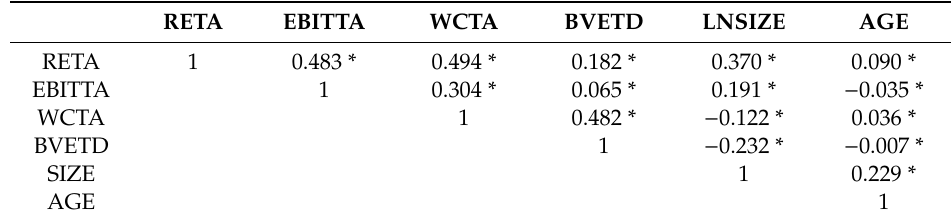
Table A1. Correlation table of